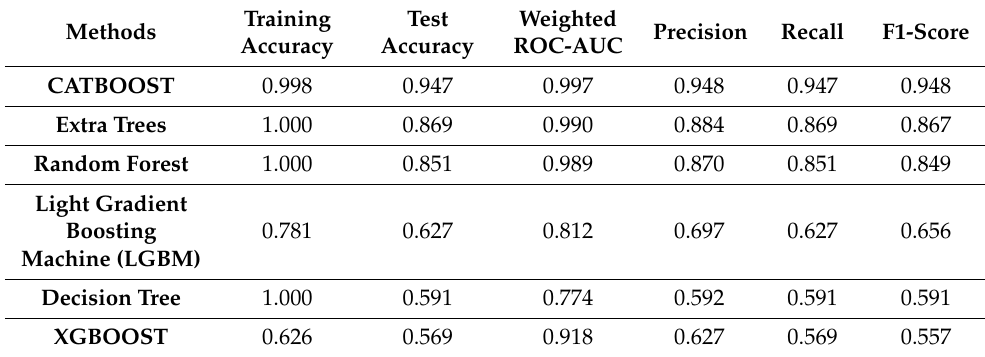
Table 3. Base model performance on various evaluation metrics.